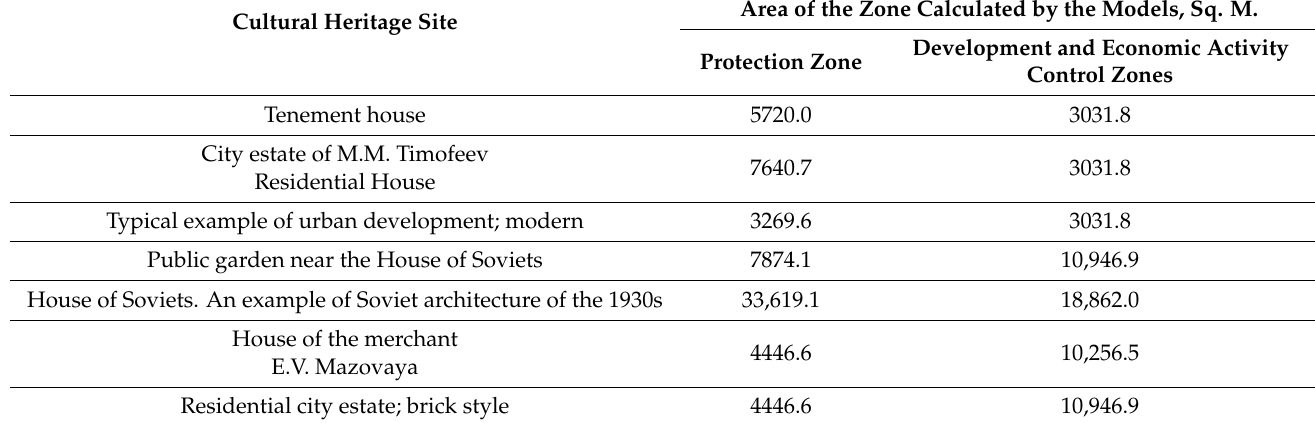
The symbol (cid:88) means that the factor is included in the model and affects the size of the zone, and the symbol O means that the factor is not included in the model and does not affect the establishment of the boundaries of this zone type.